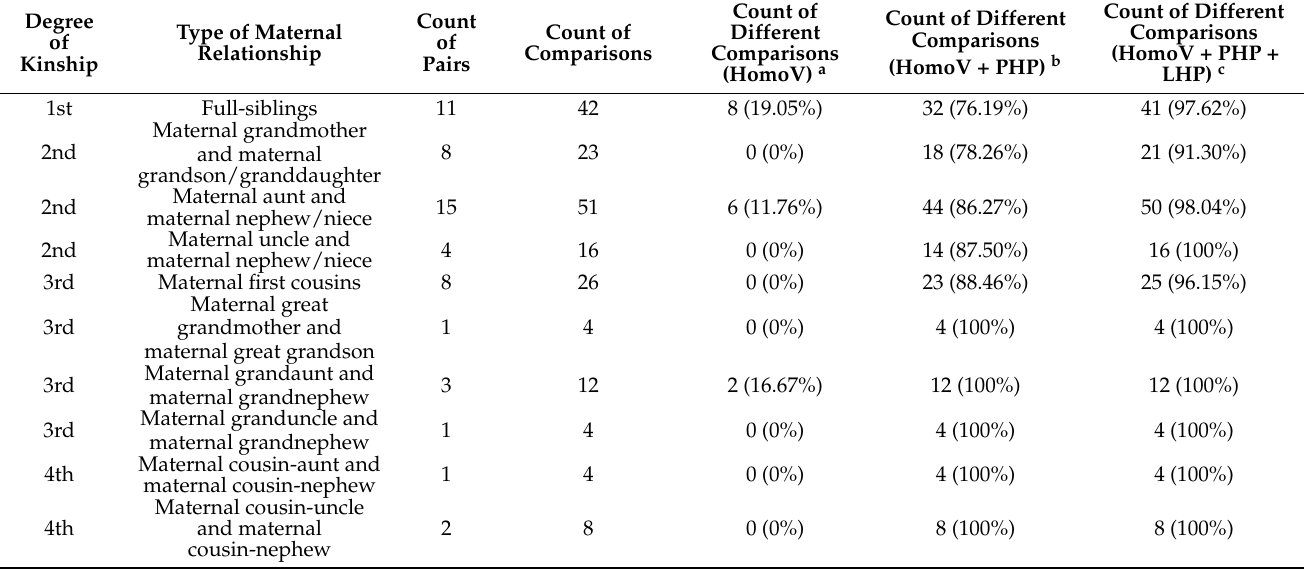
Table 6. Different mtGenome haplotypes in ten types of maternal